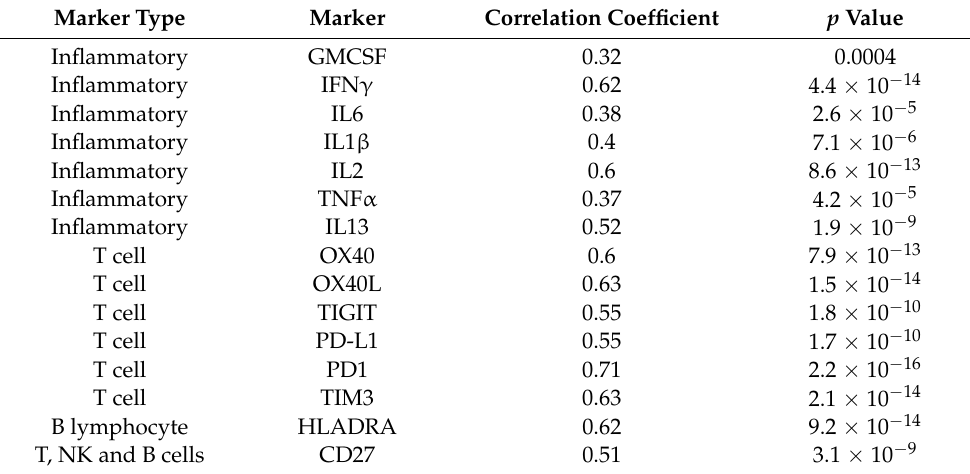
Table 1. Elevated RAD51 expression is commensurate with immune dysregulation. RAD51 expres- sion was evaluated for correlation with various immune components involved in inflammation and cellular immunity in Esophageal adenocarcinoma (dataset; GSE13898). Elevated RAD51 expression correlated with increased expression of various immune components. Marker Type